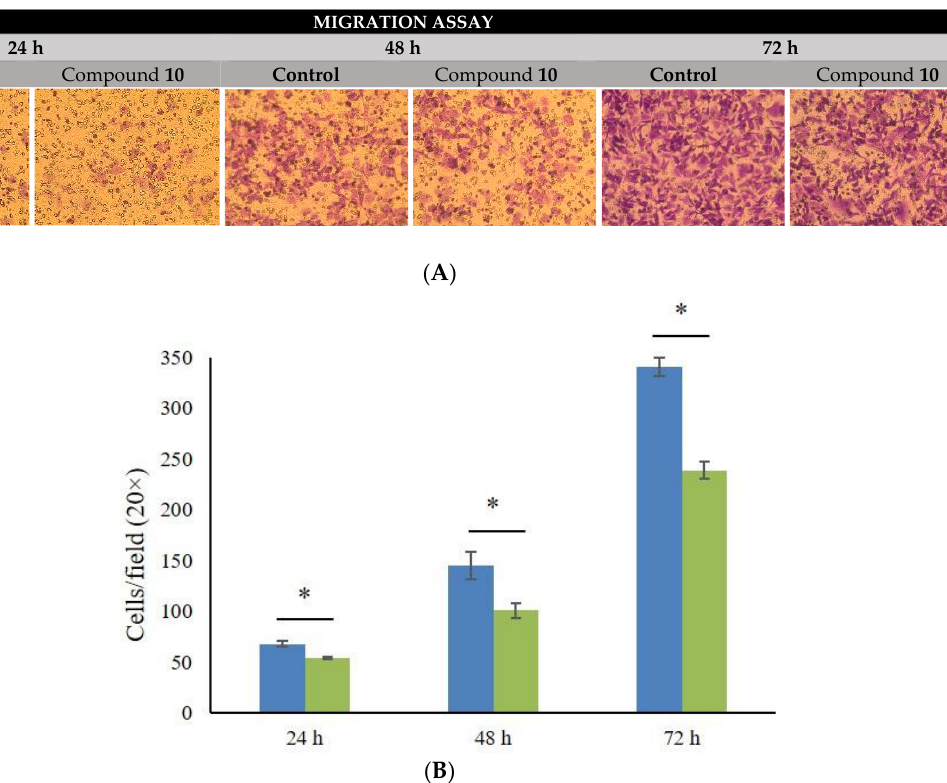
Figure 5. Effect of compound 10 on the migration capacity of MDA-MB-231 cells. ( A ) Representative images of migration assays in untreated and treated cells with 0.1 µM compound 10 for 24, 48 or 72 h. ( B ) Quantitative analysis of untreated (blue) and treated (green) migrated MDA-MB-231 cells. Data are shown as mean ± SE of at least three independent experiments. * p < 0.05.